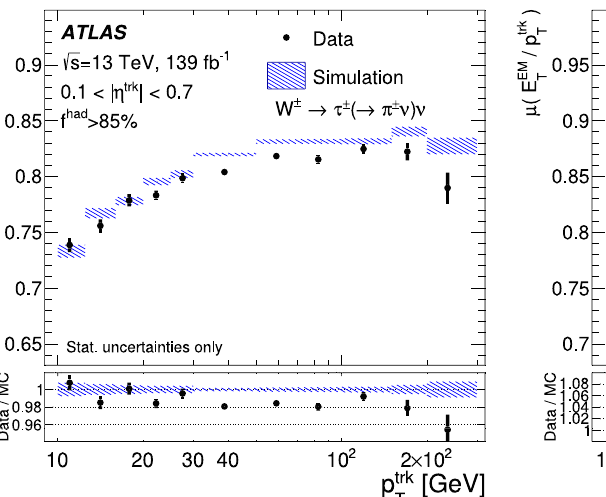
Fig. 11 The fitted response as a function of track p T in the barrel (left) and endcaps (right) after requiring the fraction of the associated energy thatisinthehadroniccalorimeterstosatisfy f had > 85%.Theerrorbars